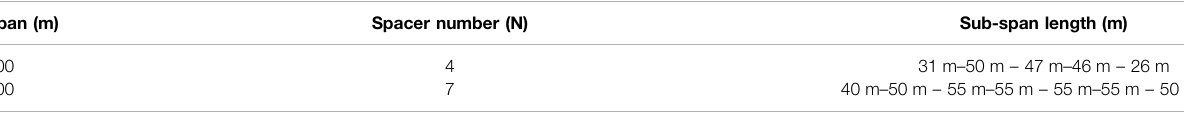
TABLE 3 | Spacer arrangement. Span (m)